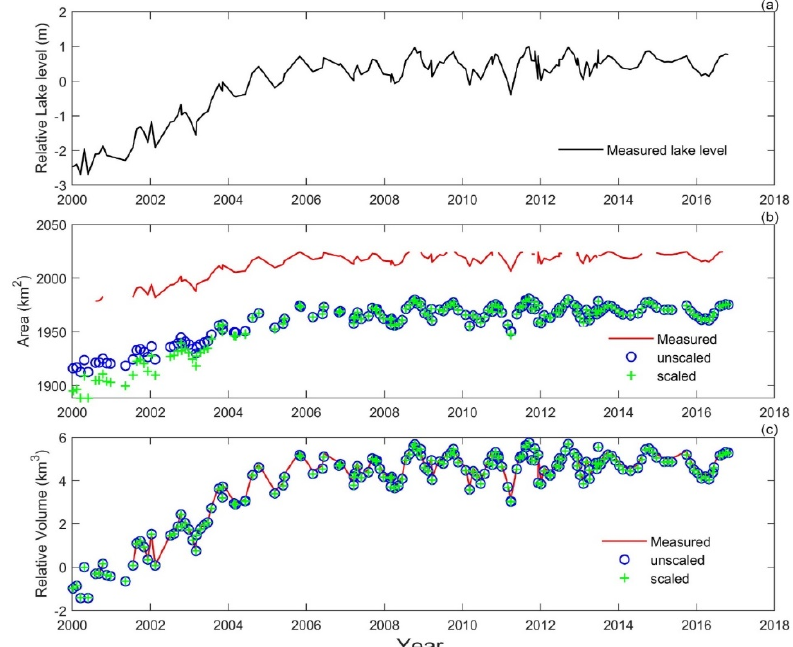
Figure 9. The ( a ) lake level from Hydroweb, ( b ) area, and ( c ) relative volume series result of the scaled model and reference data (from Hydroweb) from 2000 to 2017.